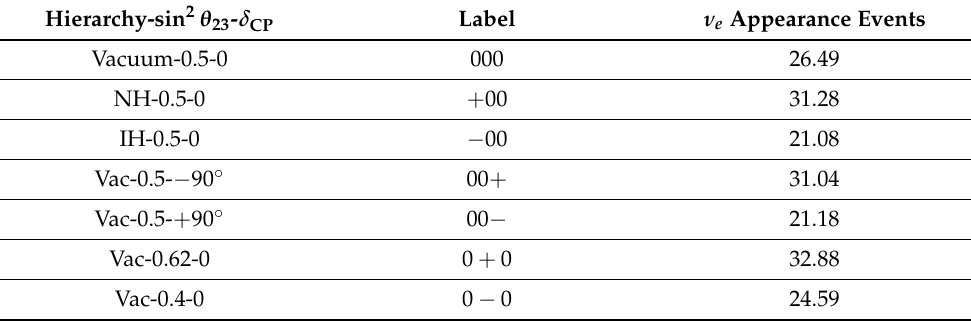
Table 3. Expected ν e appearance events of NO ν A for 6.05 × 10 20 POT. They are listed for the reference point and for change of one unknown parameter at a time. NO ν A observed 33 ν e appearance events in